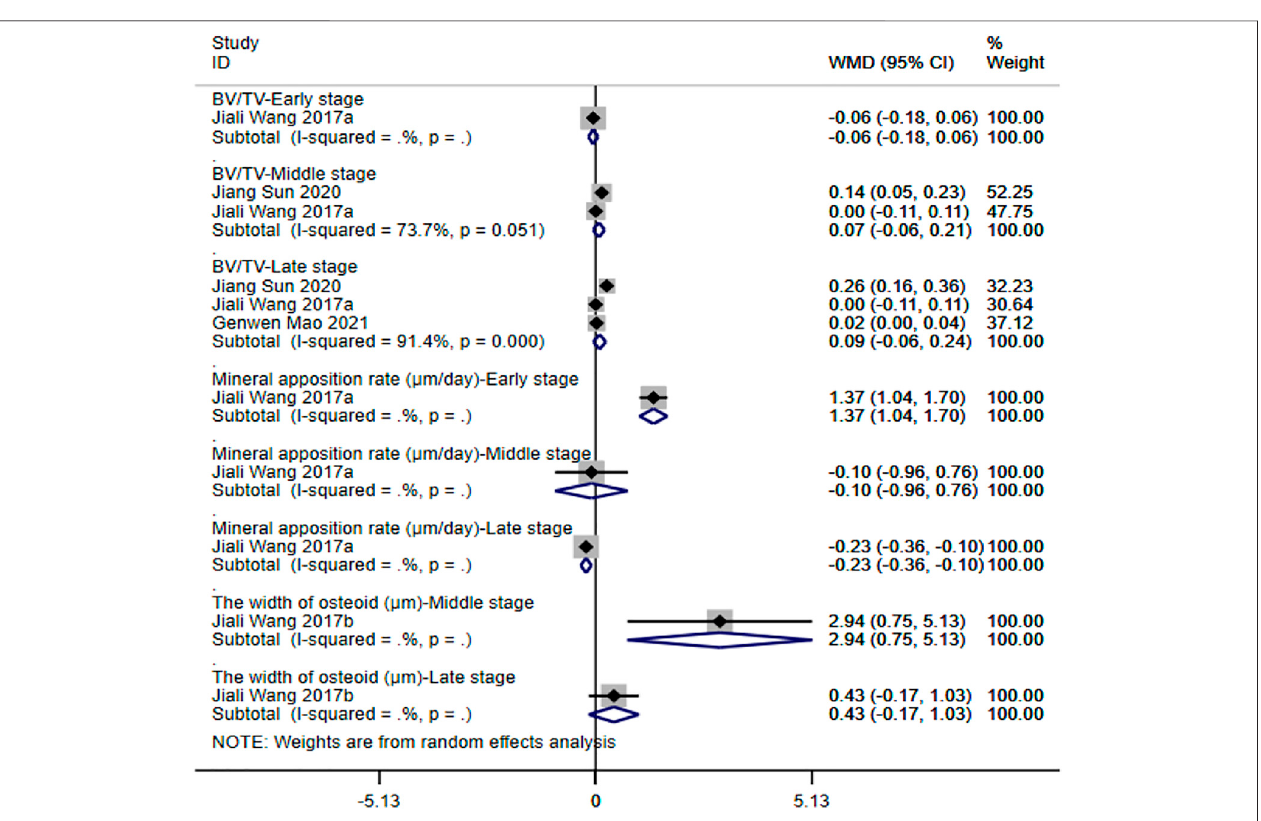
FIGURE 6 | Meta-analysis results of outcome indicators related to new bone formation of magnesium and its alloys vs. titanium and its alloys.